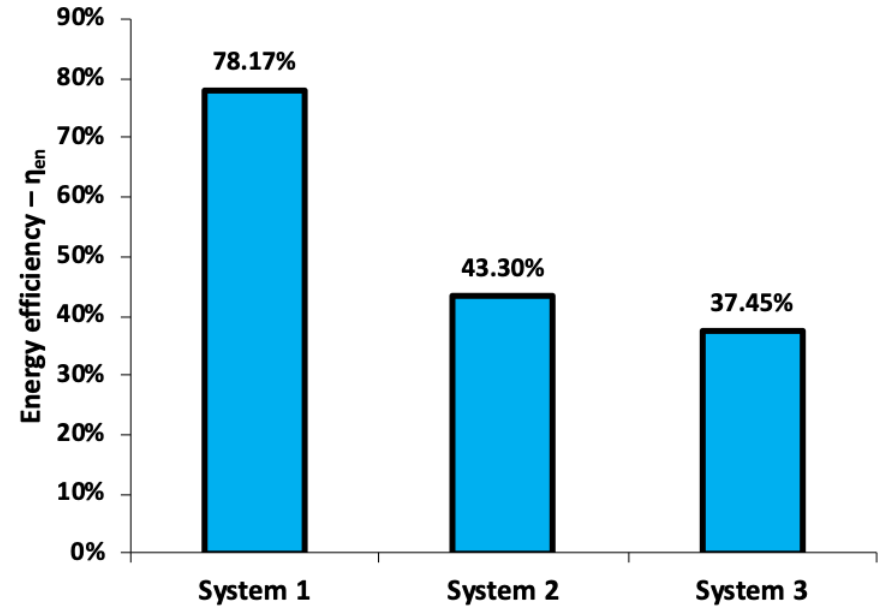
Figure 10. Energy e ffi ciency of the examined Figure 10. Energy efficiency of the examined systems.